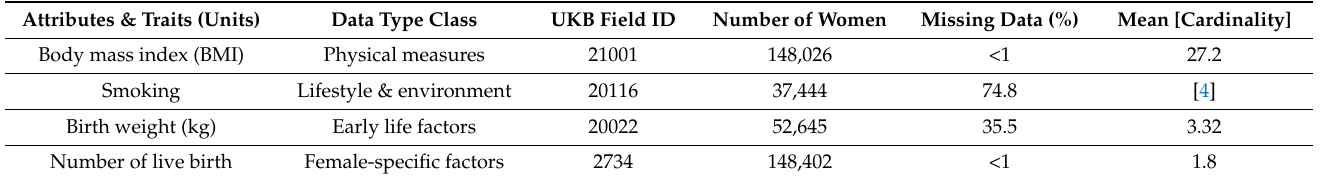
Table 1. Sample of extracted data fields from UKB used in this